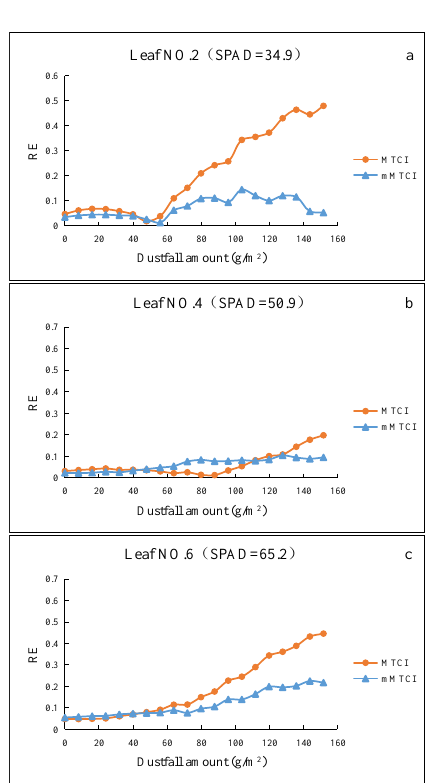
Fig. 4. MTCI and mMTCI model inversion accuracy varies with dustfall amount. (a) Leaf NO.2, (b) Leaf NO.4, (c) Leaf